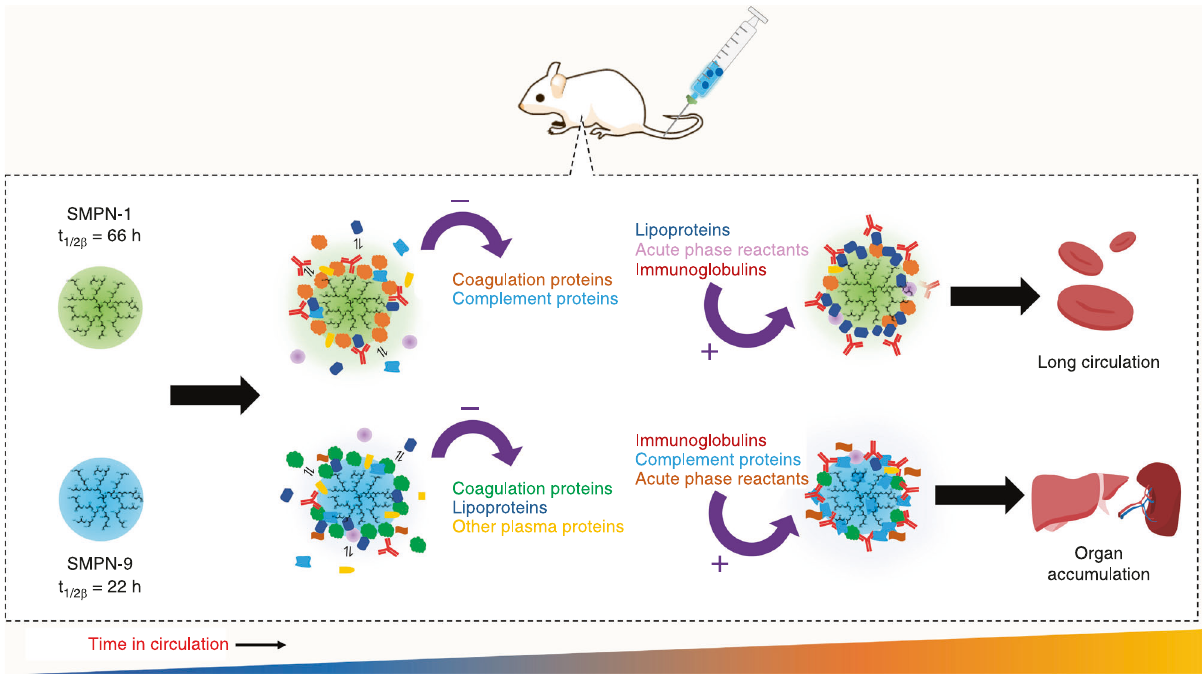
Fig. 6 A pictorial representation of formation dynamic protein fl ux on SMPNs. Coagulation and complement proteins that were absorbed initially on the surface of SMPN-1 were released during the circulation and accumulation of lipoproteins and acute phase reactants happened over 48 h on the surface. In contrast, short-circulating SMPN-9 showed with high abundance of complement proteins and acute phase reactants at 48